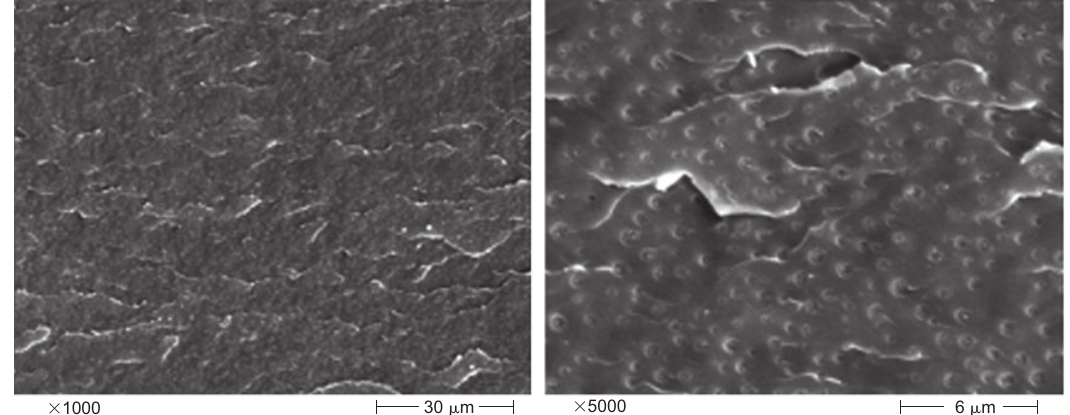
Figure 5 SEM picture from fracture surface of RTM6 ® + 5 wt %